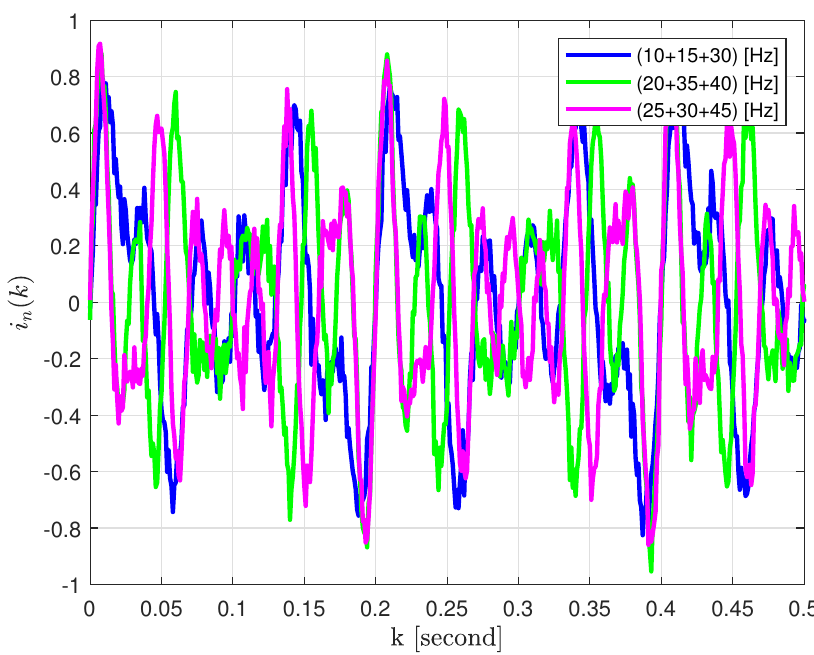
Figure 8. Multiple sinusoidal current signal measurement.